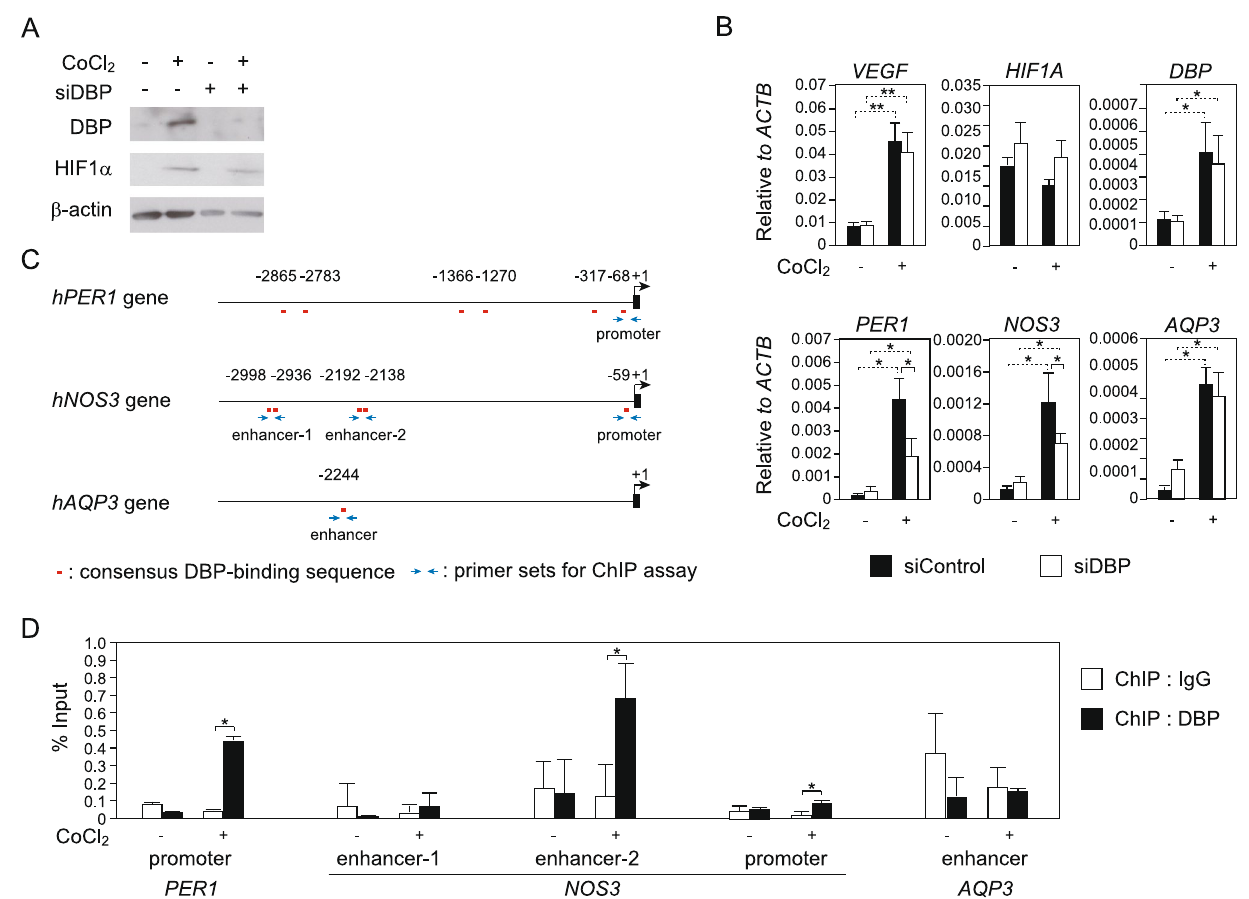
Figure 4. DBP-mediated gene expression under hypoxic conditions in human bladder smooth muscle cells. ( A ) DBP protein levels in human bladder smooth muscle cells under hypoxic conditions. BdSMC cells were transfected with siDBP and cultured with CoCl 2 solution for 24 h (0 or 500 mM). Western blotting was performed with anti-DBP and anti-HIF1α antibodies. ( B ) mRNA levels of DBP-knockdown BdSMC cells under hypoxic conditions. BdSMC cells were transfected with siDBP and treated with CoCl 2 for 24 h. RT-qPCR was used to measure gene expression. Measurements show average values of 3 independent measurements, which were normalized to ACTB mRNA expression. ** P < 0.01, * P < 0.05. ( C ) A schematic of gene loci of human PER1 , NOS3 and AQP3 . Locations of DBP-binding sequences are shown as red bars. Blue arrows indicate primers for ChIP assay. (D) ChIP assay with anti-DBP antibody using BdSMC cell lysate. BdSMC cells were cultured with 500 mM CoCl 2 solution for 0 h or 4 h. Immunoprecipitated DNA fragments were quantified by qPCR. Each primer set is shown in Table S3. Data are means ± SEM for three independent experiments. * P <